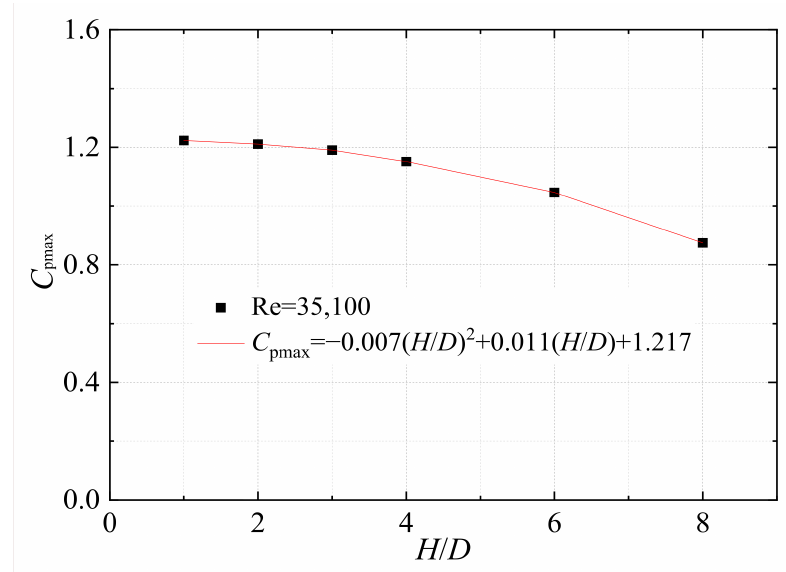
Figure 17. Change in maximum pressure coefficient C pmax on the impact wall at different impact heights H/D